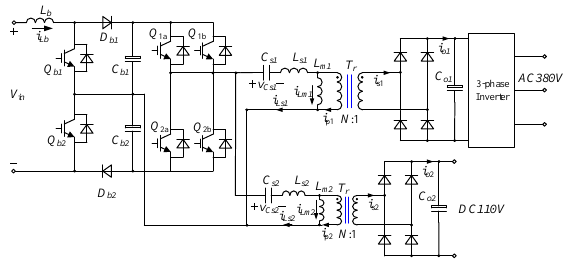
Figure 1. Novel auxiliary power supply for urban rail transit train.